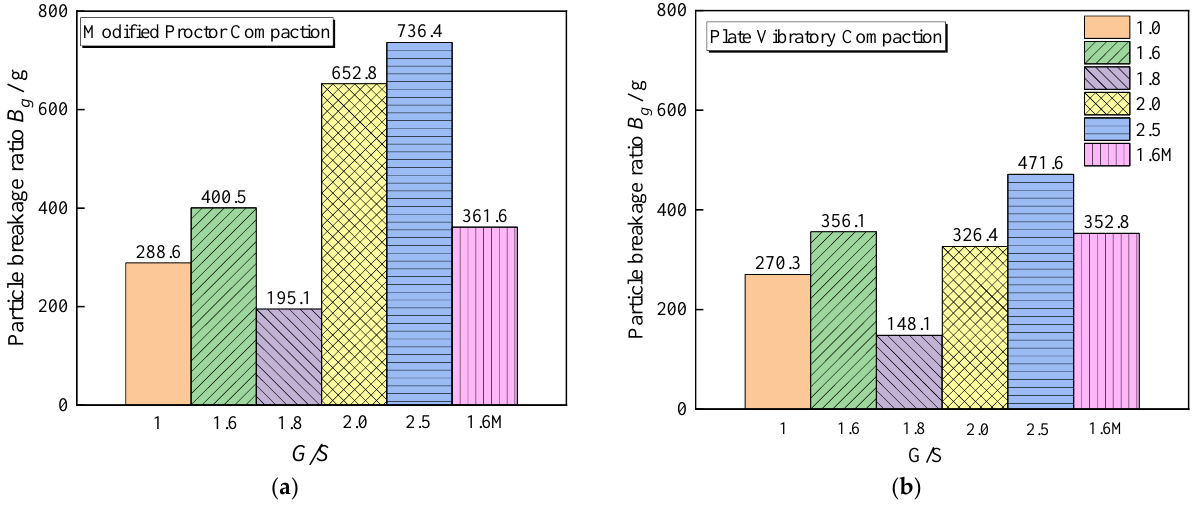
Figure 14. Particle breakage Bg values for UPAB specimens with different G / S levels under: ( a ) Mod- ified proctor compaction; ( b ) Plate vibratory compaction with 30 Hz frequency.